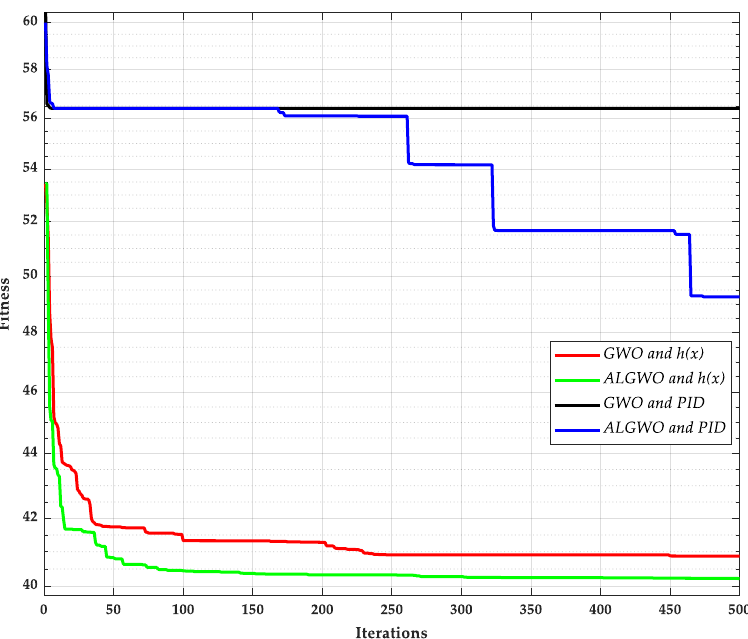
Figure 15. The comparison results of algorithm optimization search on test system 6.